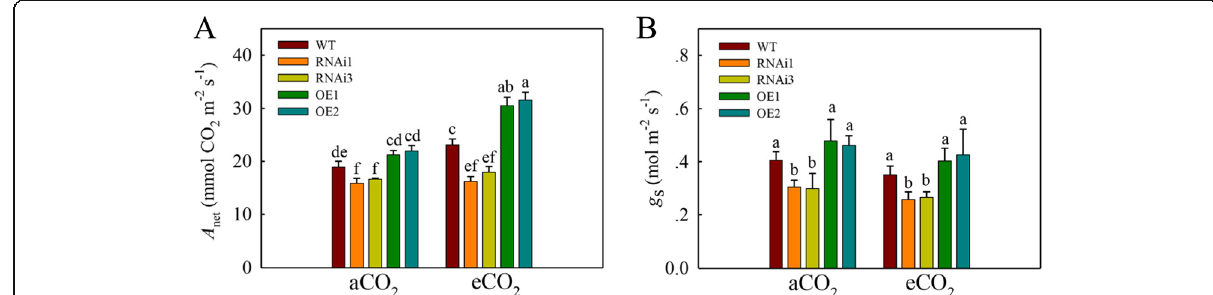
Fig. 4 Effects of eCO 2 on the net rate of CO 2 assimilation ( A net ) and stomatal conductance ( g s ) in WT, RNAi lines and OE lines of qPE9-1 . Rice plants (the OE lines, WT and RNAi lines) were grown under aCO 2 or eCO 2 in growth chambers for 4 weeks. ( A ) Net rate of CO 2 assimilation ( n = 5). ( B ) stomatal conductance ( g s ) ( n = 5). All values are means± SD; different letters indicate significant differences ( P <